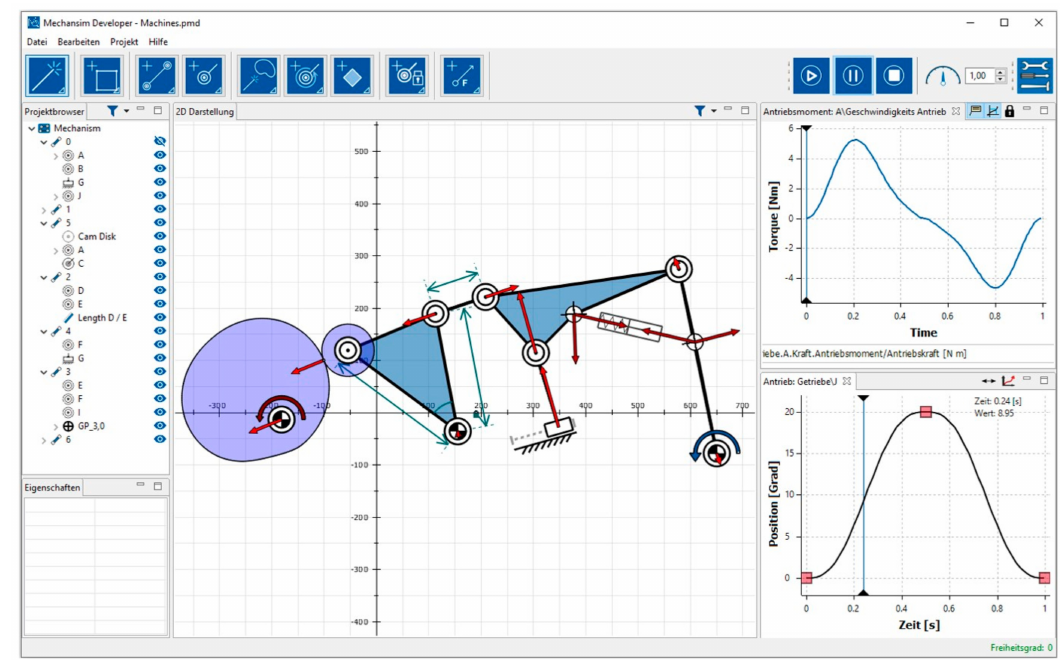
Figure 1. Screenshot of the Software MechDev to explain the di ff erent